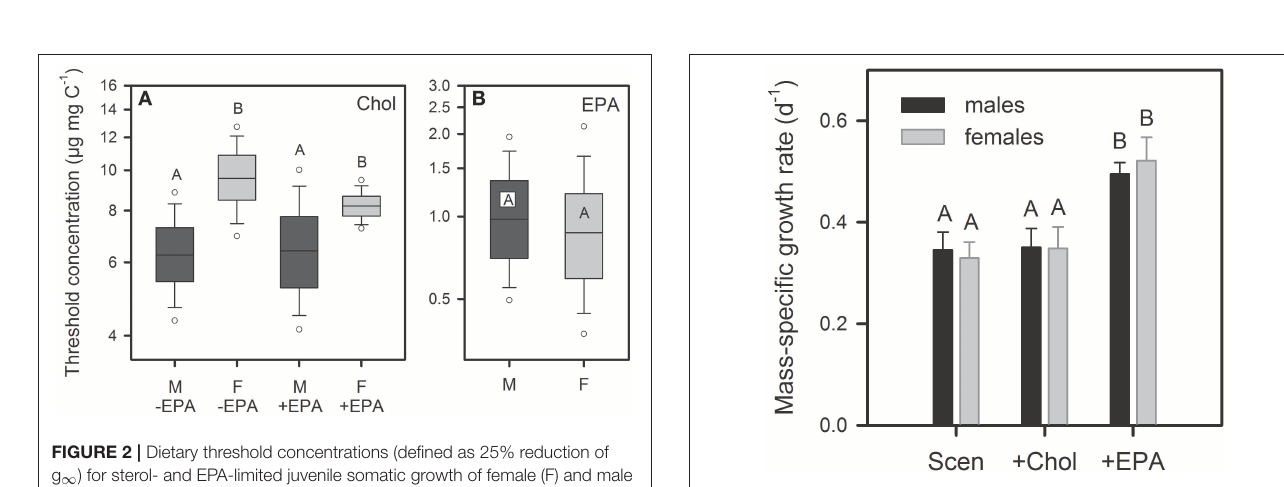
FIGURE 3 | Mass-specific juvenile somatic growth rates of female and male D. magna reared on S. obliquus and S. obliquus supplemented with cholesterol or EPA. Growth rates were calculated from the increase in body dry mass up to day four of the experiment. Data represent means of n = 6 ± standard deviation (SD). Bars labeled with the same letters are not significantly different (Tukey’s HSD, P < 0.05, following ANOVA).